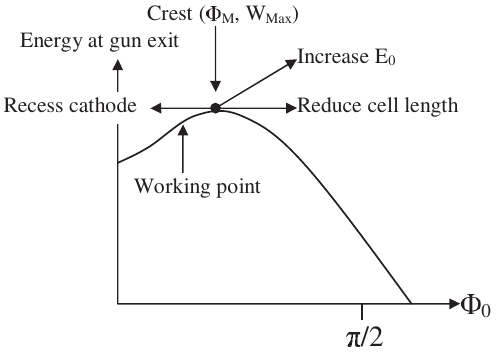
FIG. 6. The energy at gun’s exit as a function of the initial